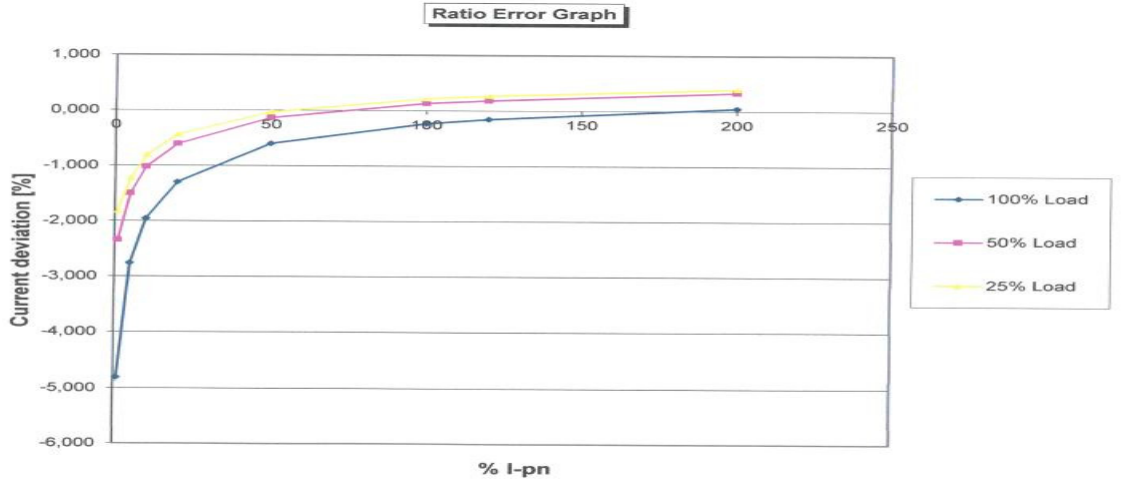
Figure 10. Factory testing results of ratio error.